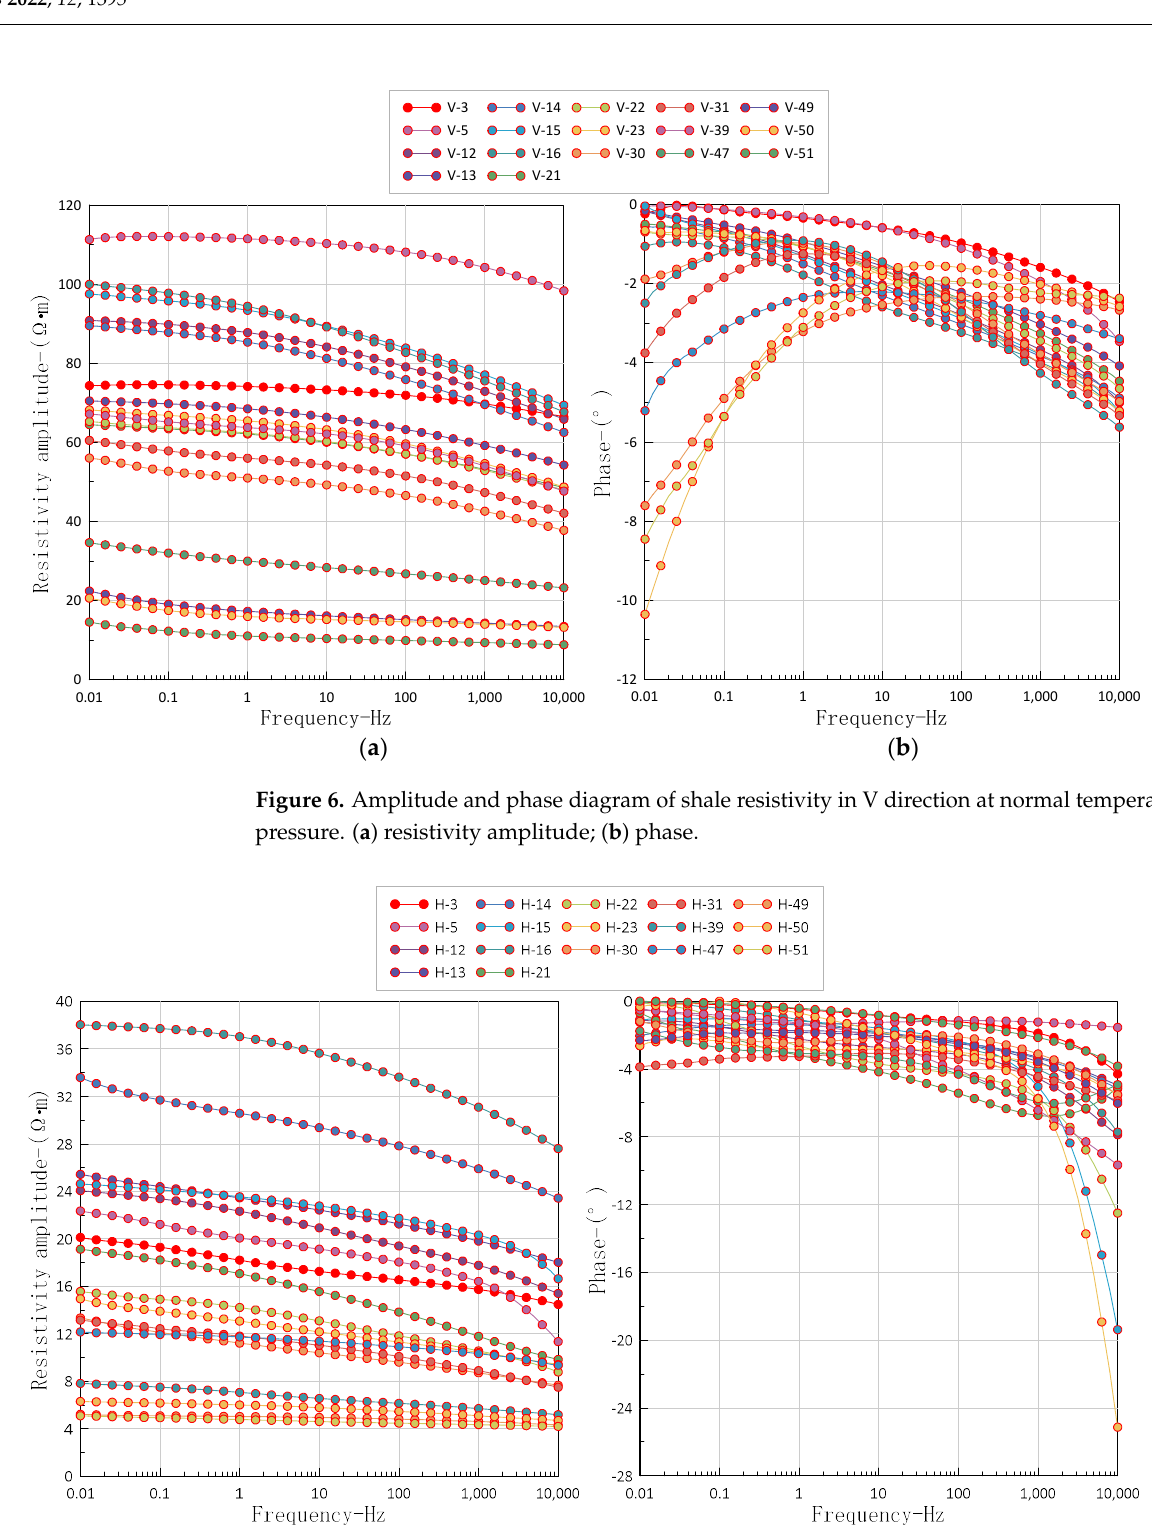
Figure 7. Amplitude and phase diagram of shale resistivity in H direction at high temperature and pressure. ( a ) resistivity amplitude; ( b ) phase.